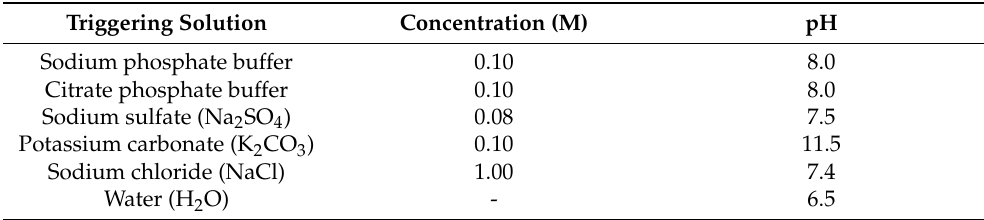
Table 1. Solutions tested for the release of enzymes from LDH. Triggering Solution Concentration (M) pH Sodium phosphate buffer 0.10 Citrate phosphate